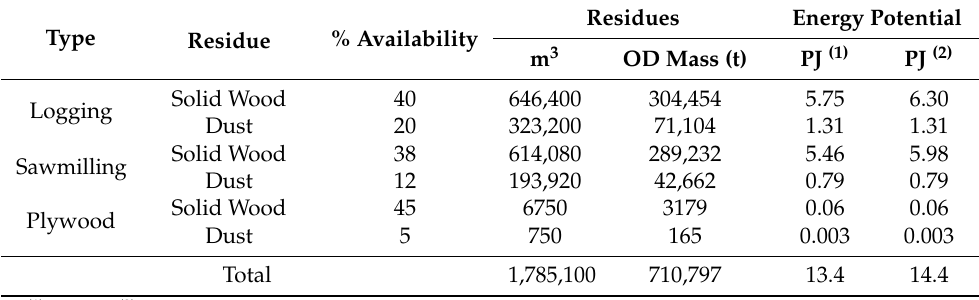
Table 7. The EP available from the forestry residues in Tanzania.